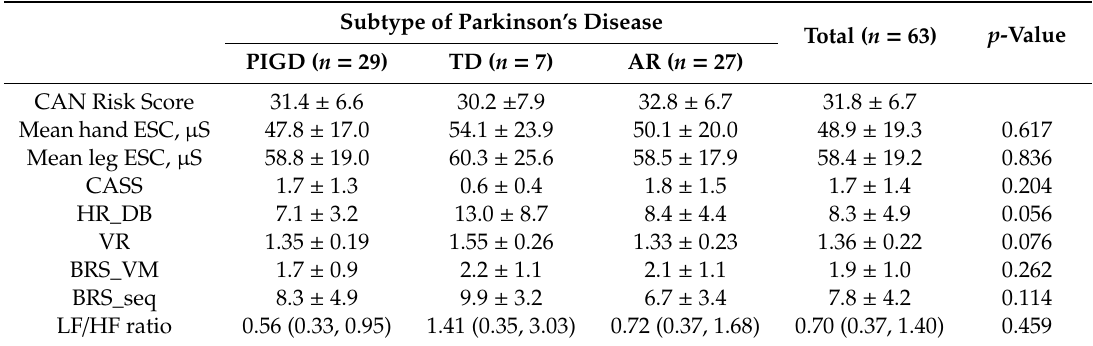
Table 2. Comparison of cardiovascular autonomic function among subtypes of Parkinson’s disease.